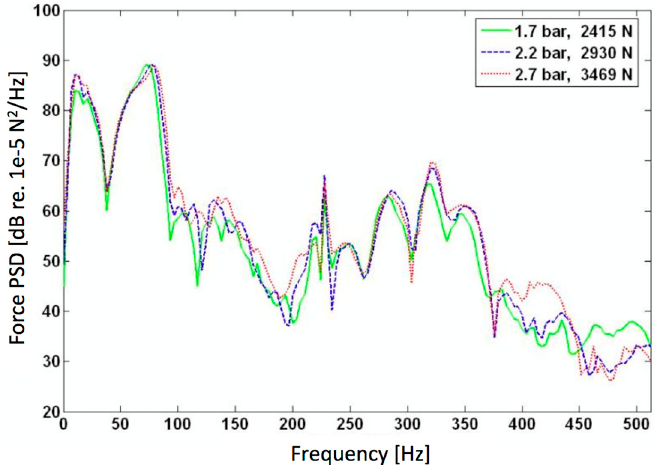
Figure 6. Vertical spindle force spectrum at different inflation pressures; driving over 5 mm high semi-circular cleat at speed of 22.6 km/h (modified from Kindt et al., 2007 [72], Figure 8).